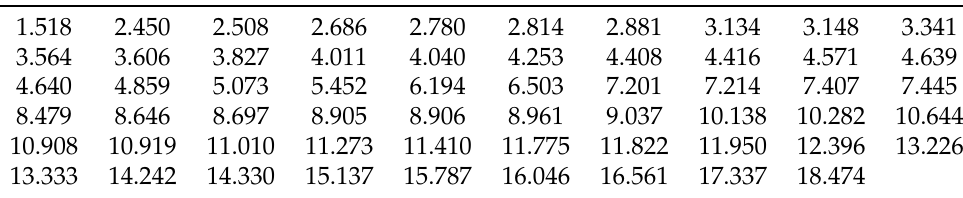
Table 8. COVID-19 data set of Italy.